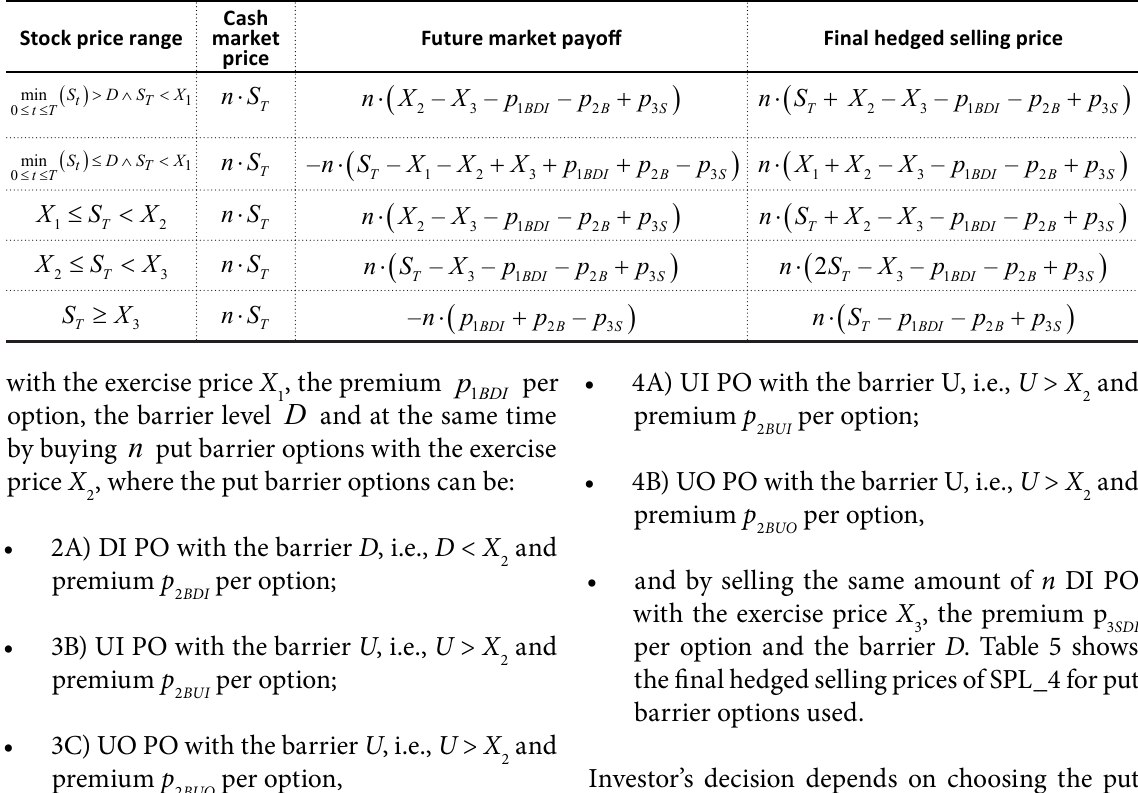
Table 3. Final hedged selling prices using Short Put Ladder option strategy_2A